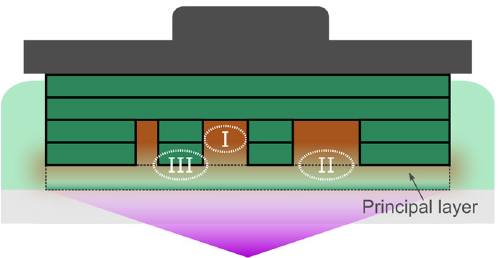
Figure 2. Interaction between the blocking liquid and the resin in the bottom-up stereolithography system. Schematic showing regions of interaction between the resin (light green) and the blocking liquid (orange) after substitution of the blocking liquid and during the polymerization of the principal layer. Mixing between the two liquids occurs when the part containing the blocking liquid filled trenches is brought into contact with the resin pool. The effect of liquid mixing within Regions I, II and III are discussed throughout the main text.